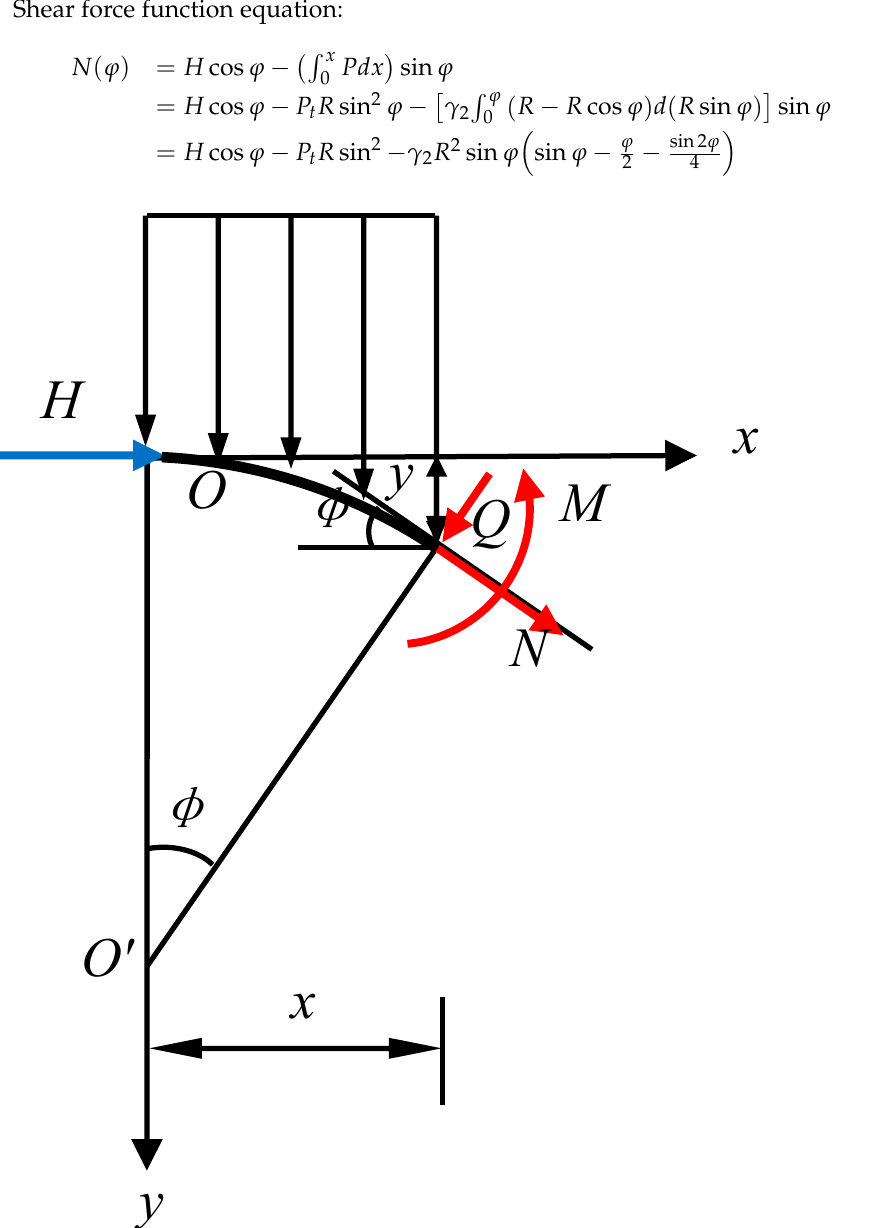
Figure 9. Force diagram of isolated part at any section of the three-hinged arch.